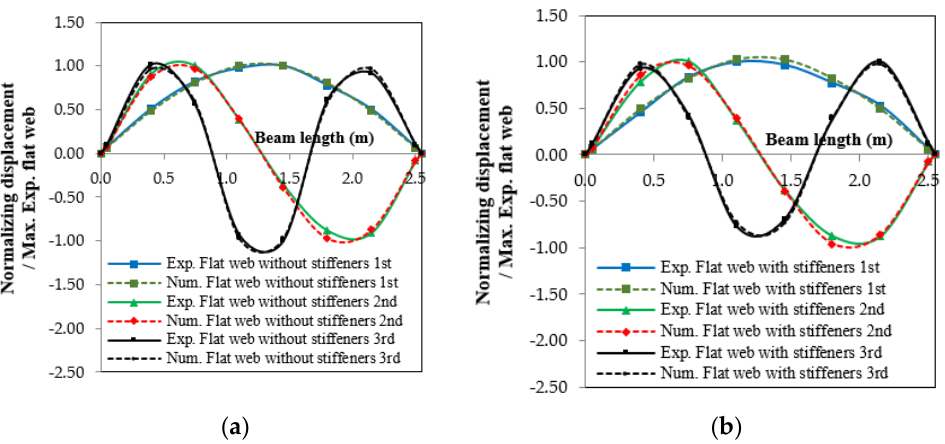
Figure 5. Curves showing the normalized displacements’ mode shapes gained from both experimental and FE simulations: ( a ) flat web without stiffeners and ( b ) flat web with stiffeners. Table 2. Comparison of experimental and numerical results for the flat web beam without stiffeners.